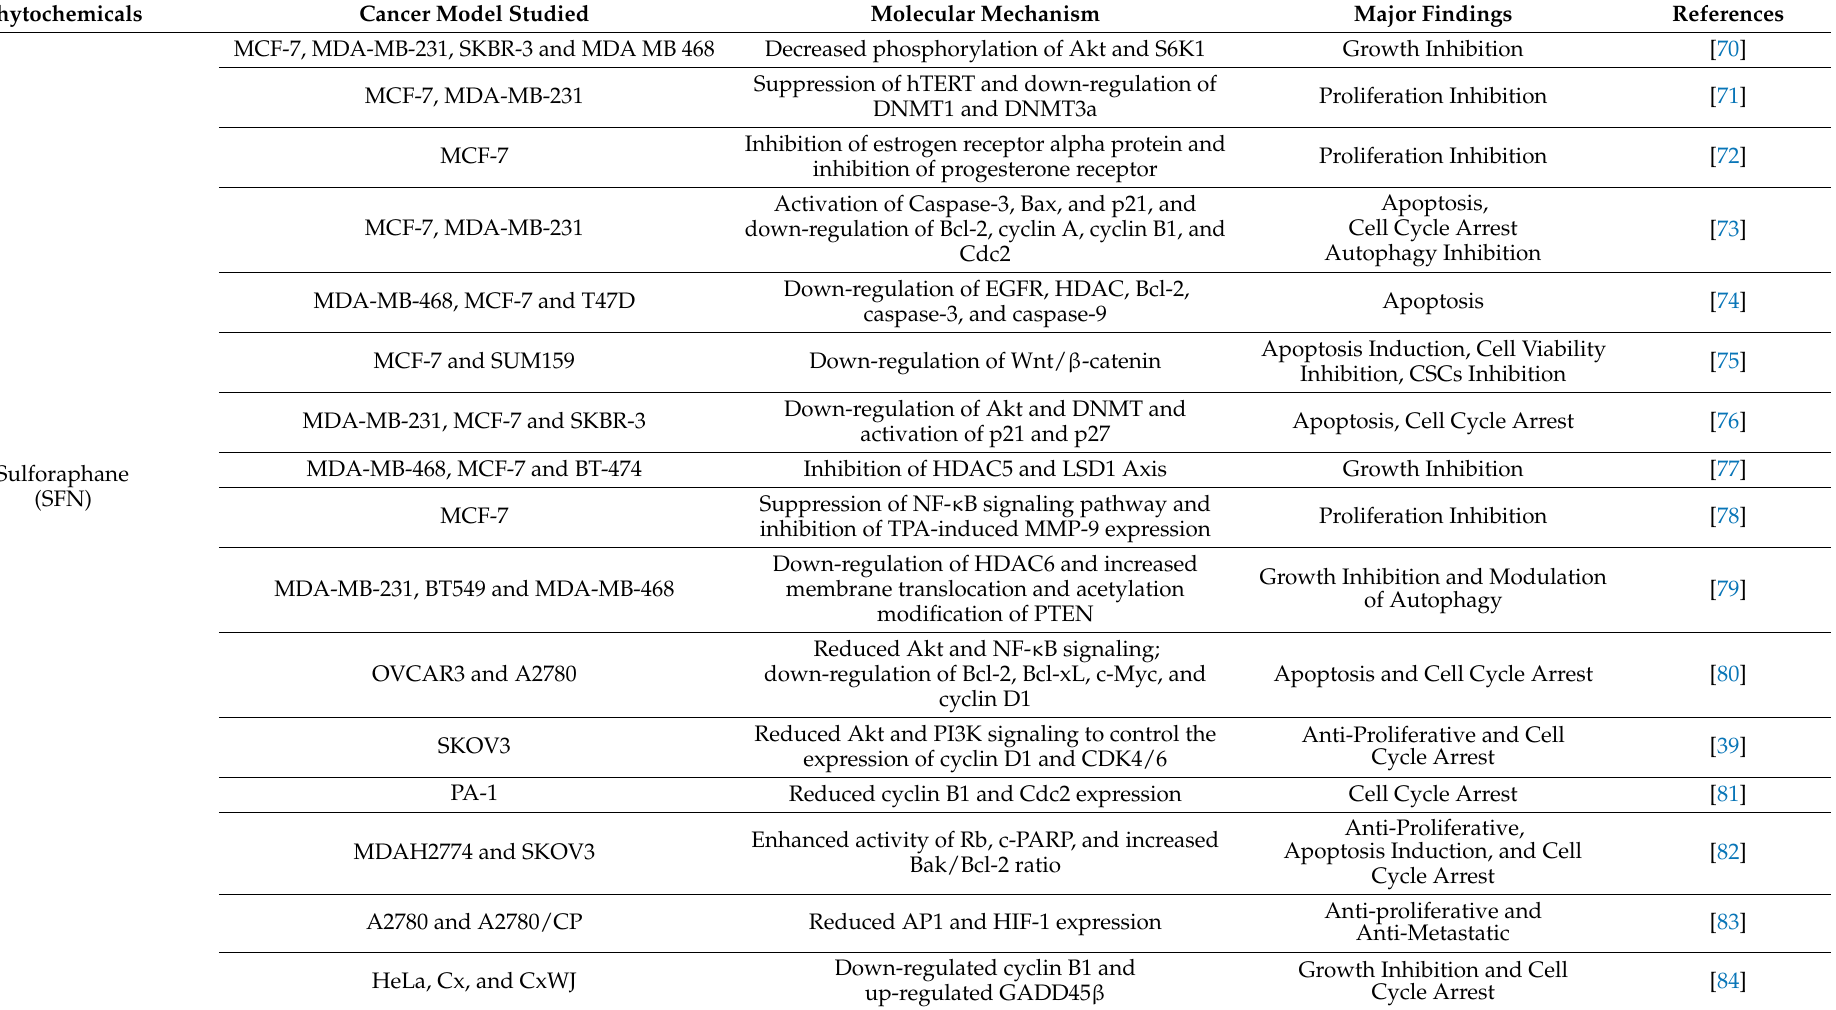
Table 2. Representative table highlighting the molecular intricacies of various isothiocyanates against female-specific